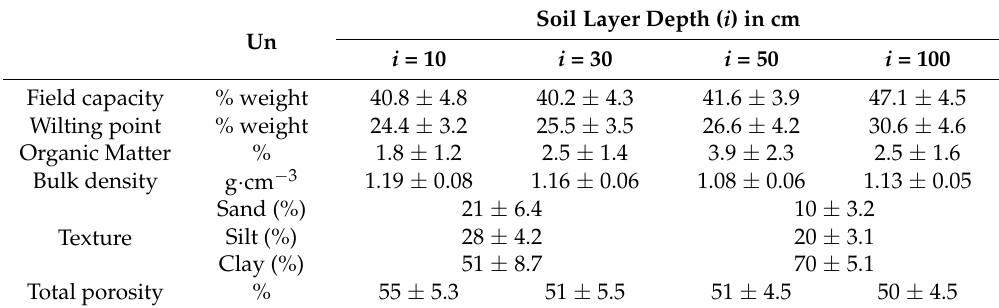
Table 1. Summary of relevant soil physical variables based on four soil pits. Average values ±